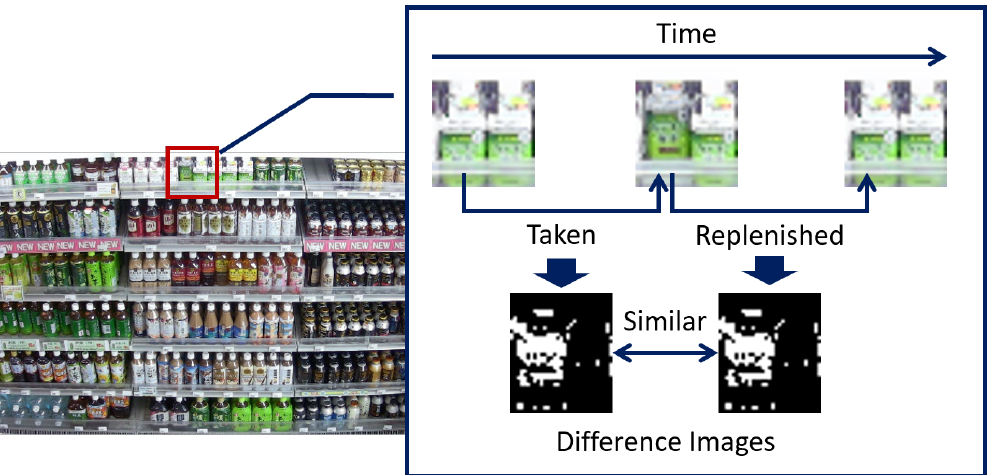
Figure 6. Examples of difference images for change regions of “product taken” and “product